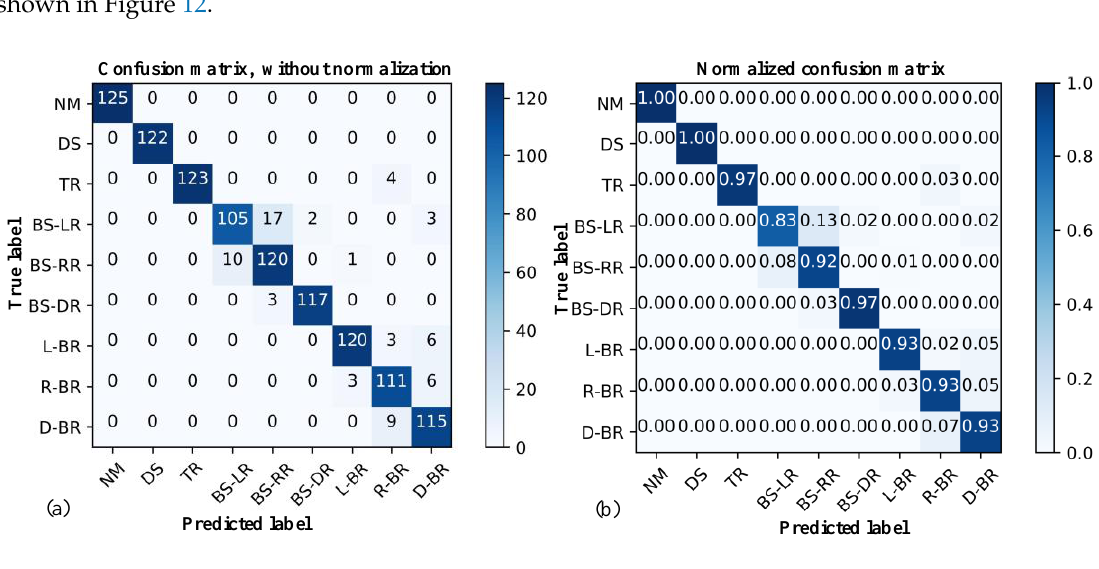
Figure 12. The k-nearest neighbor (KNN) confusion matrices. ( a ) Without normalization; ( b ) The k-nearest neighbor (KNN) confusion normalized.